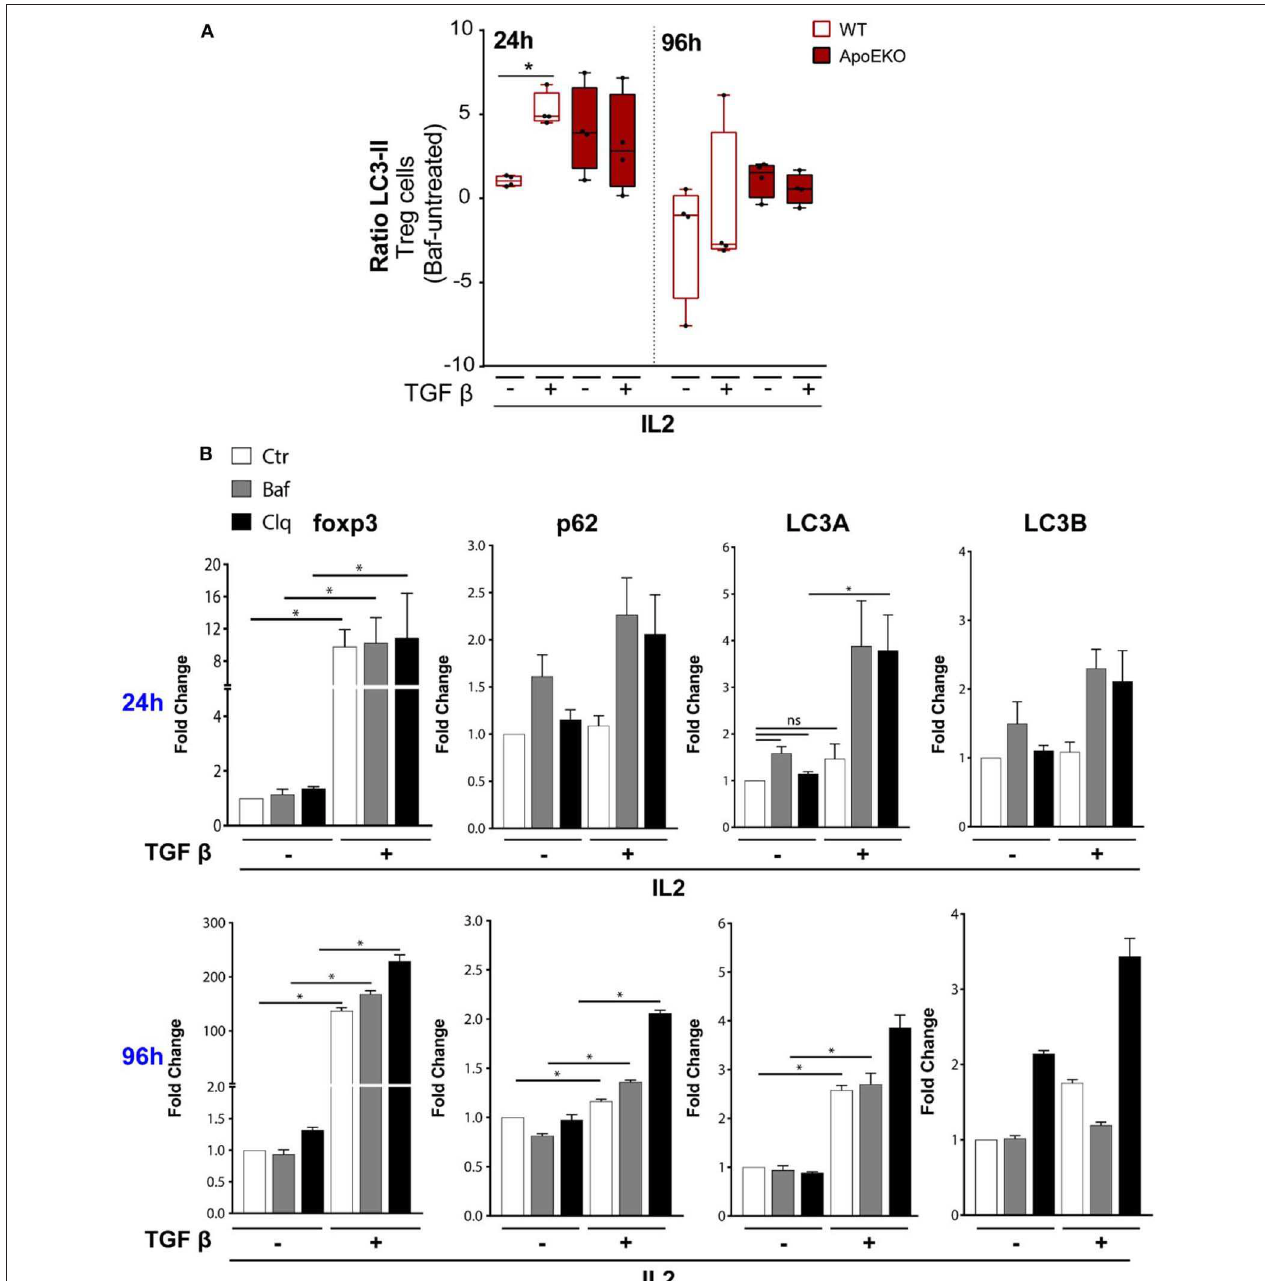
FIGURE 4 | (A) Autophagic flux during Tregs differentiation in wt ( n = 4) and ApoE-KO mice ( n = 4). Tregs were induced by culturing naïve CD4 + T cells isolated from splenocytes, in the presence of IL2 (100 U/ml) treated or not with TGF β (2ng/ml) and stimulated with plate-bound anti-CD3 and anti-CD28. The histograms show flow cytometry analysis for 24 and 96h with and without bafilomycin (represented as LC3-II ratio: Baf-untreated) during the last 4h of stimulation. * P < 0.05, ** P < 0.01, *** P < 0.001, by two-way analysis of variance (ANOVA). (B) Quantitative RTqPCR analysis of TGF β -induced Tregs from naïve CD4 + T cells isolated from wt mice, in the presence of IL2 and stimulated with plate-bound anti-CD3 and anti-CD28 for 24h ( n = 3, 2 mice per experiment) and 96h ( n = 2, 8 mice per experiment). All the experiments were performed with and without bafilomycin (100nM) or chloroquine (40 µ M) during the last 4h of differentiation. * P < 0.05, ** P < 0.01, *** P < 0.001, by unpaired t -test,